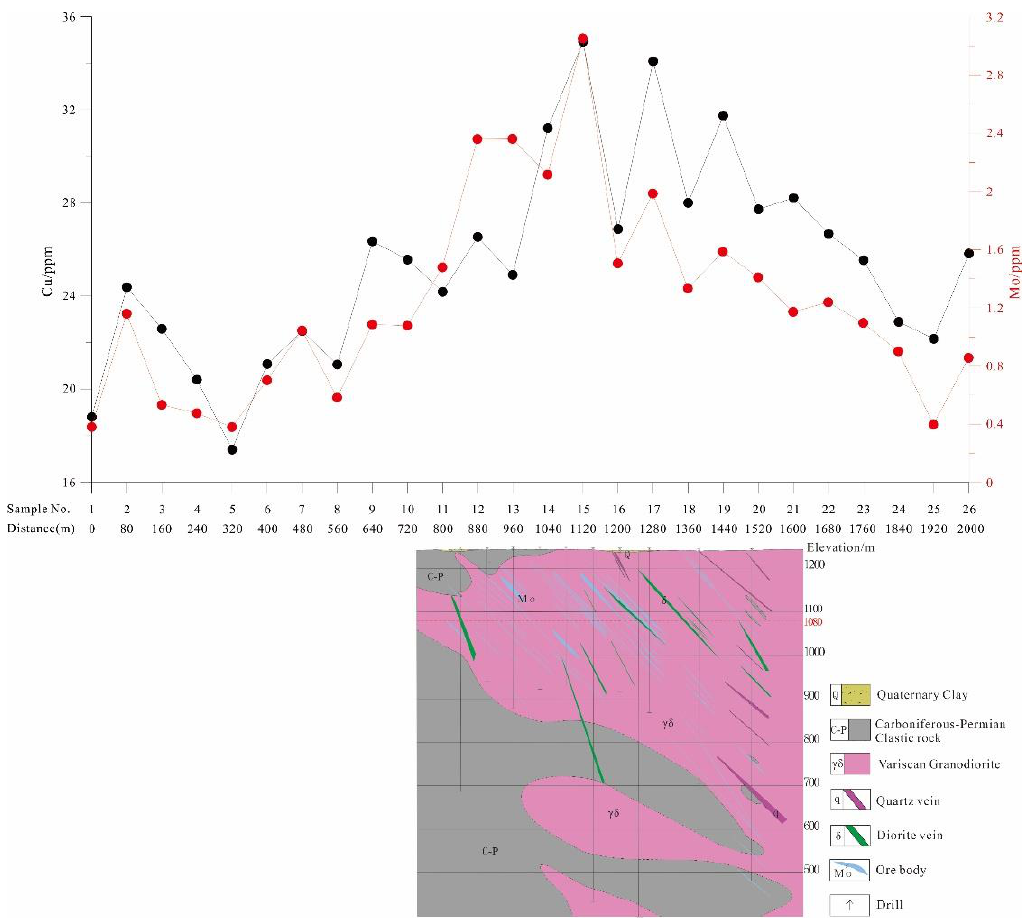
Figure 9. Cu and Mo line chart of fine-fraction soil samples (<76 μm) across the concealed ore body in the Zhunsujihua deposit.